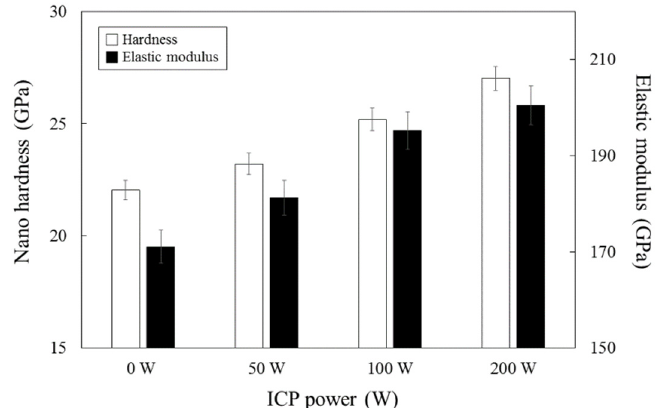
Figure 6. Nanoindentation hardness and elastic modulus of MoN coatings deposited using ICP assisted sputtering with various ICP powers.